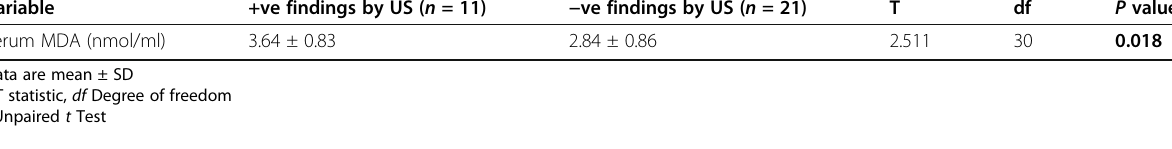
Table 5 Relation between MDA and presence of cranial ultrasound evidence of HIE Variable +ve findings by US ( n = 11) − ve findings by US ( n = 21)